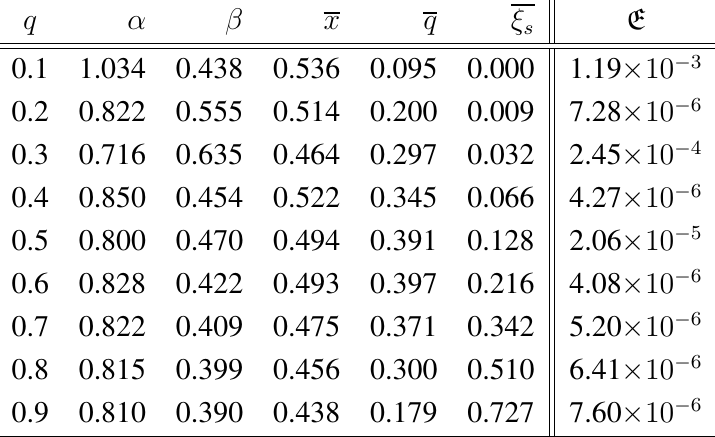
Table 2 . Fit parameters of the Havriliak-Negami [90] expression to scaled permittivity, Equation (5). The error E is calculated with Equation